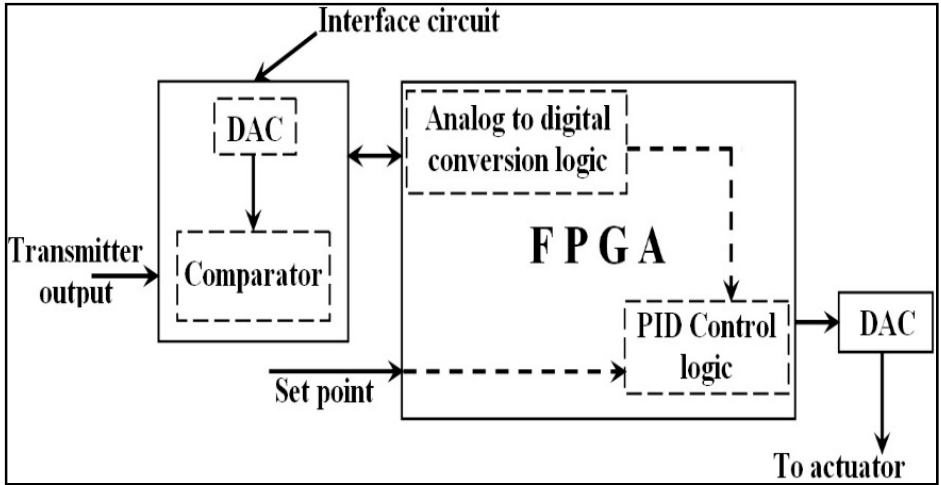
Figure 2. FPGA design of single closed-loop control system.